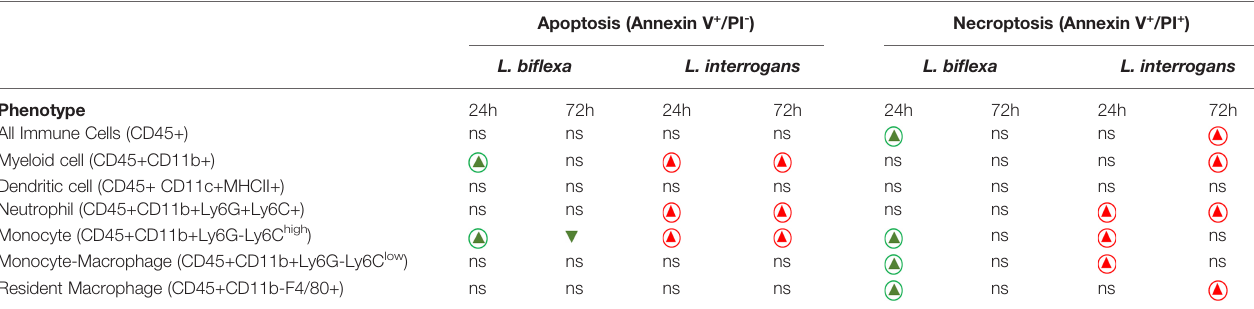
TABLE 1 | Summary of cell death processes in different immune cells after Leptospira infection.